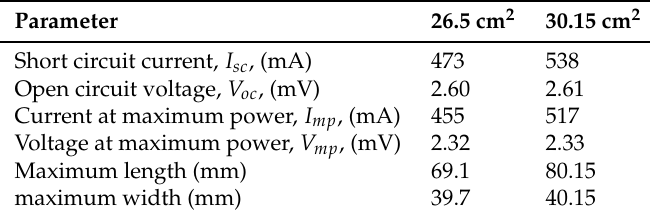
Table 3. Parameters of triple junction cells for cells of 26.5 cm 2 and 30.15 cm 2 for standard conditions (1367 W/m 2 , 28 ◦